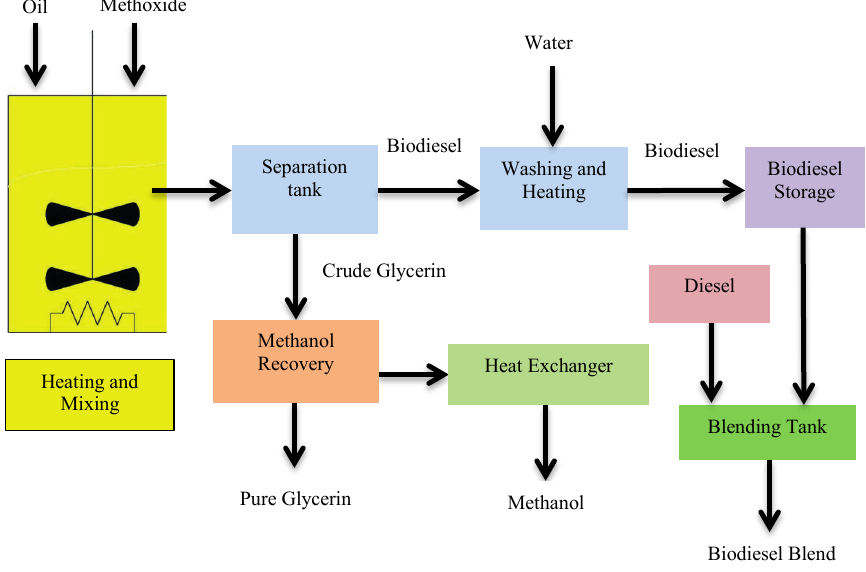
Fig. 2. Process flow diagram of overall Biodiesel Production